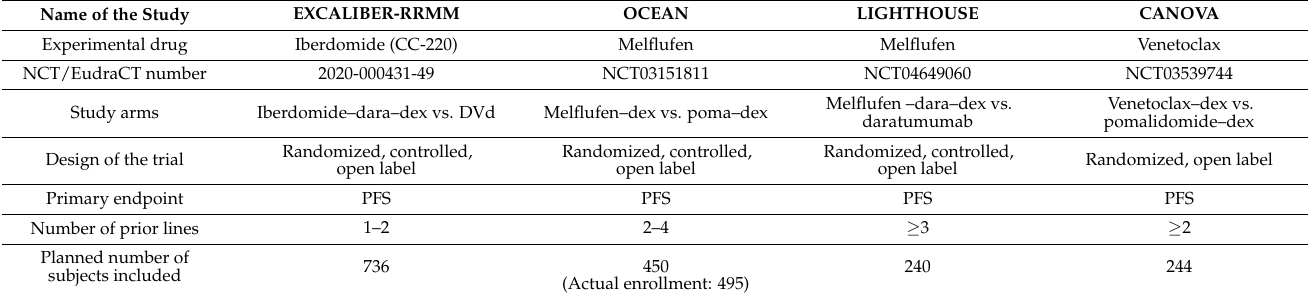
Table 2. Ongoing phase III trials investigating the main non-immunologic drugs for relapsed or refractory multiple